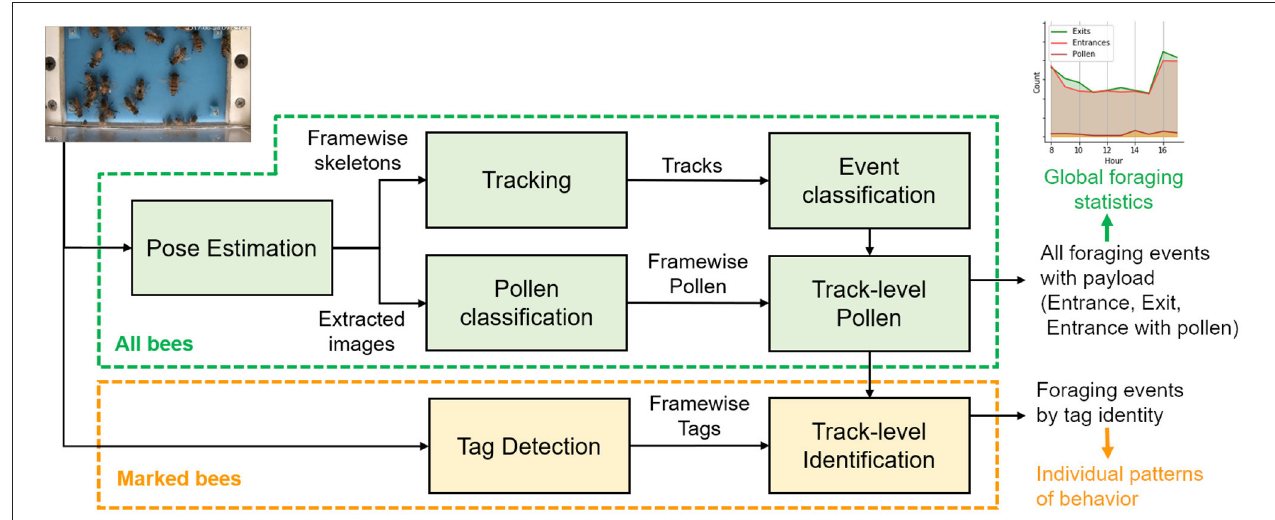
FIGURE 1 | Overview of the video analysis modules. In green, the base system can be applied uniformly to both unmarked and marked bees to detect all foraging events and produce aggregated statistics including global information of pollen intake. In orange, the identification module extends the base system to associate events to tagged bees to produce actograms for detailed analysis of behavior at the individual level.